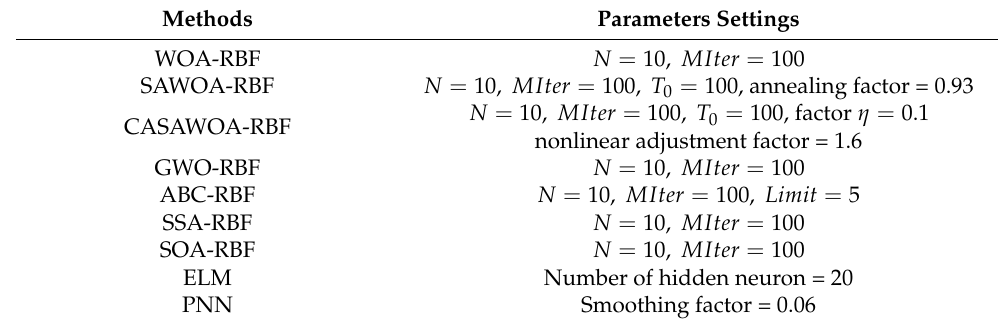
Table 7. Detailed parameters of each